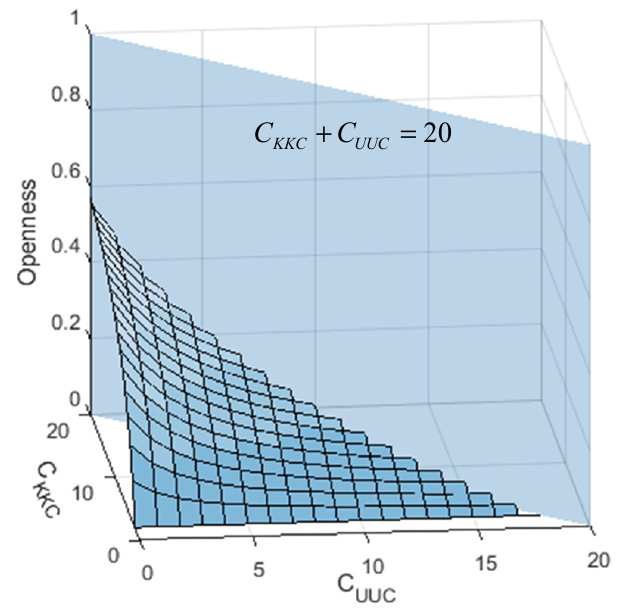
Figure 11. The openness with different numbers of KKC and UUC devices.